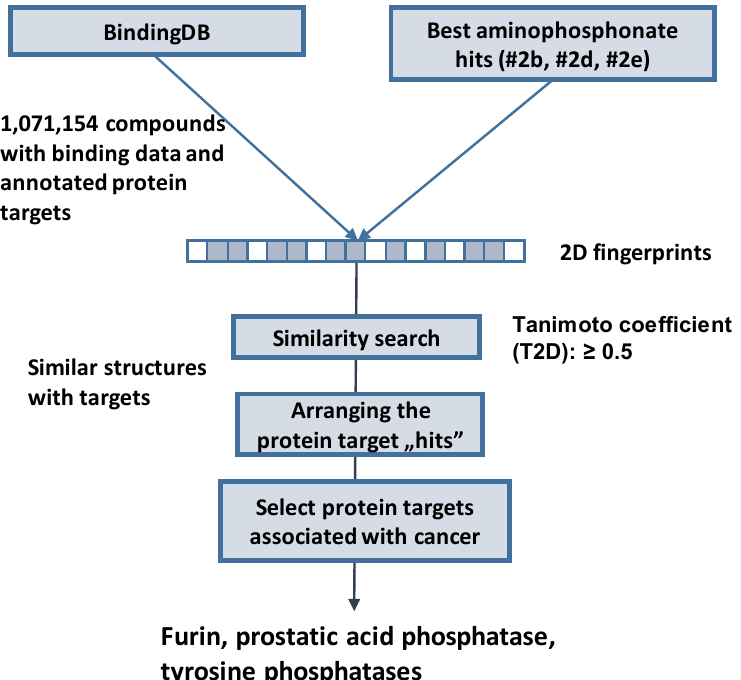
Figure 2. The work fl ow of the in silico target prediction. Figure 2. The workflow of the in silico target